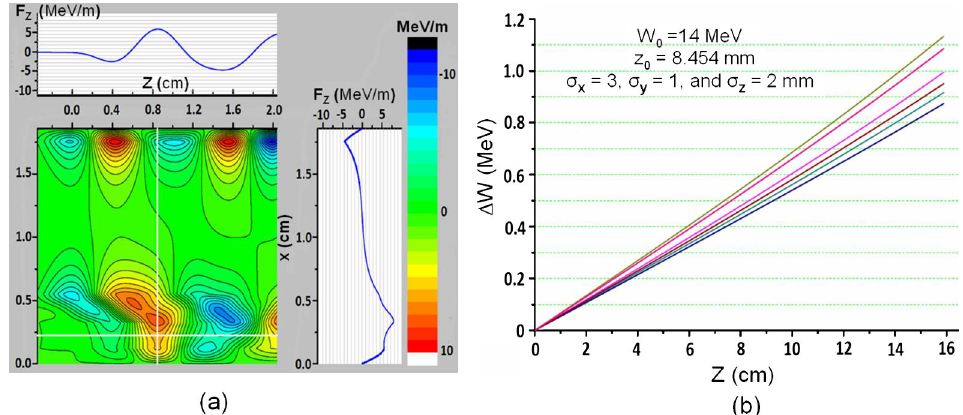
FIG. 5. (a) The composite axial force F z ð z; x Þ in the plane y ¼ 0 . The middle of the test bunch is at the white cross-hair (IVF computations at Kharkov Institute). (b) Trajectories of test particles for a monoenergetic test bunch with the initial rms length (cid:1) 2 mm (see comments in the